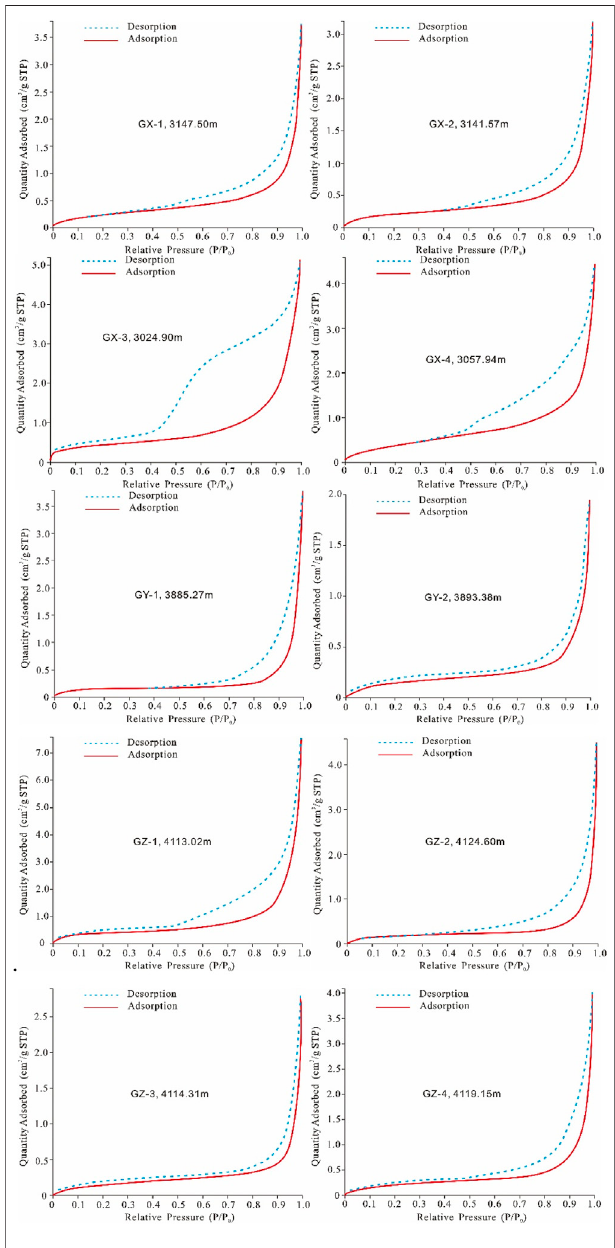
FIGURE 6 | The N 2 adsorption/desorption experiment results at low temperature (77 K) for the shale samples collected from the study area.